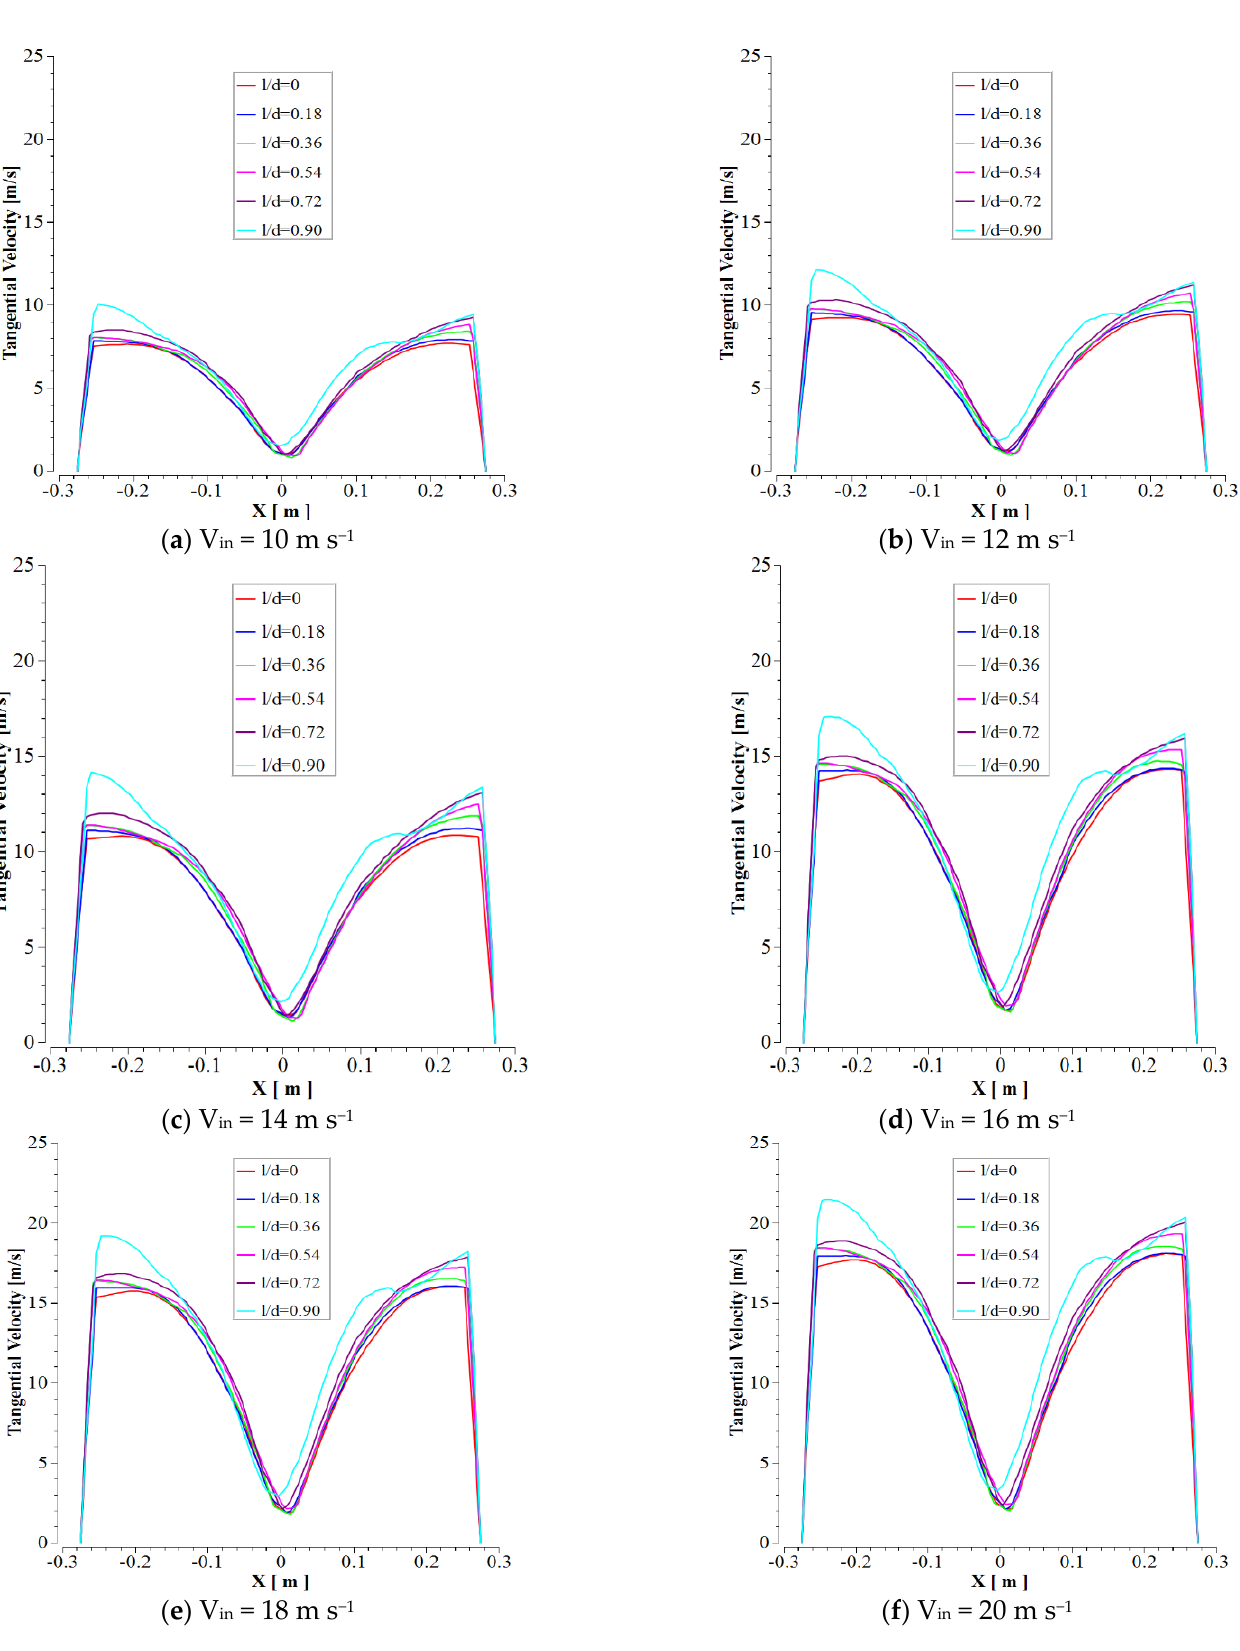
Figure 10. Tangential velocity variation in various cyclone cylinder heights. In the different situations of axial velocity contours in various mass flow rates, ap- plying the different mass flow rates has a direct effect on tangential velocity. Referring to Figure 11, the tangential velocity reduced to 21.7 m s −1 for the mass flow ra te of 0.5 kg s −1 (decrement of 0.36 m.s −1 ), whereas this decrement was 0.4 at mass flow rate of 0.1 k /s and the axial velocity reached 21.3 m s −1 . Increasing the mass flow rate regarding constant inlet velocity (16 m s −1 ) resulted in the decrement of the tangential component of the velocity field. These patterns of contours and plots for static pressure, axial and tangential velocity